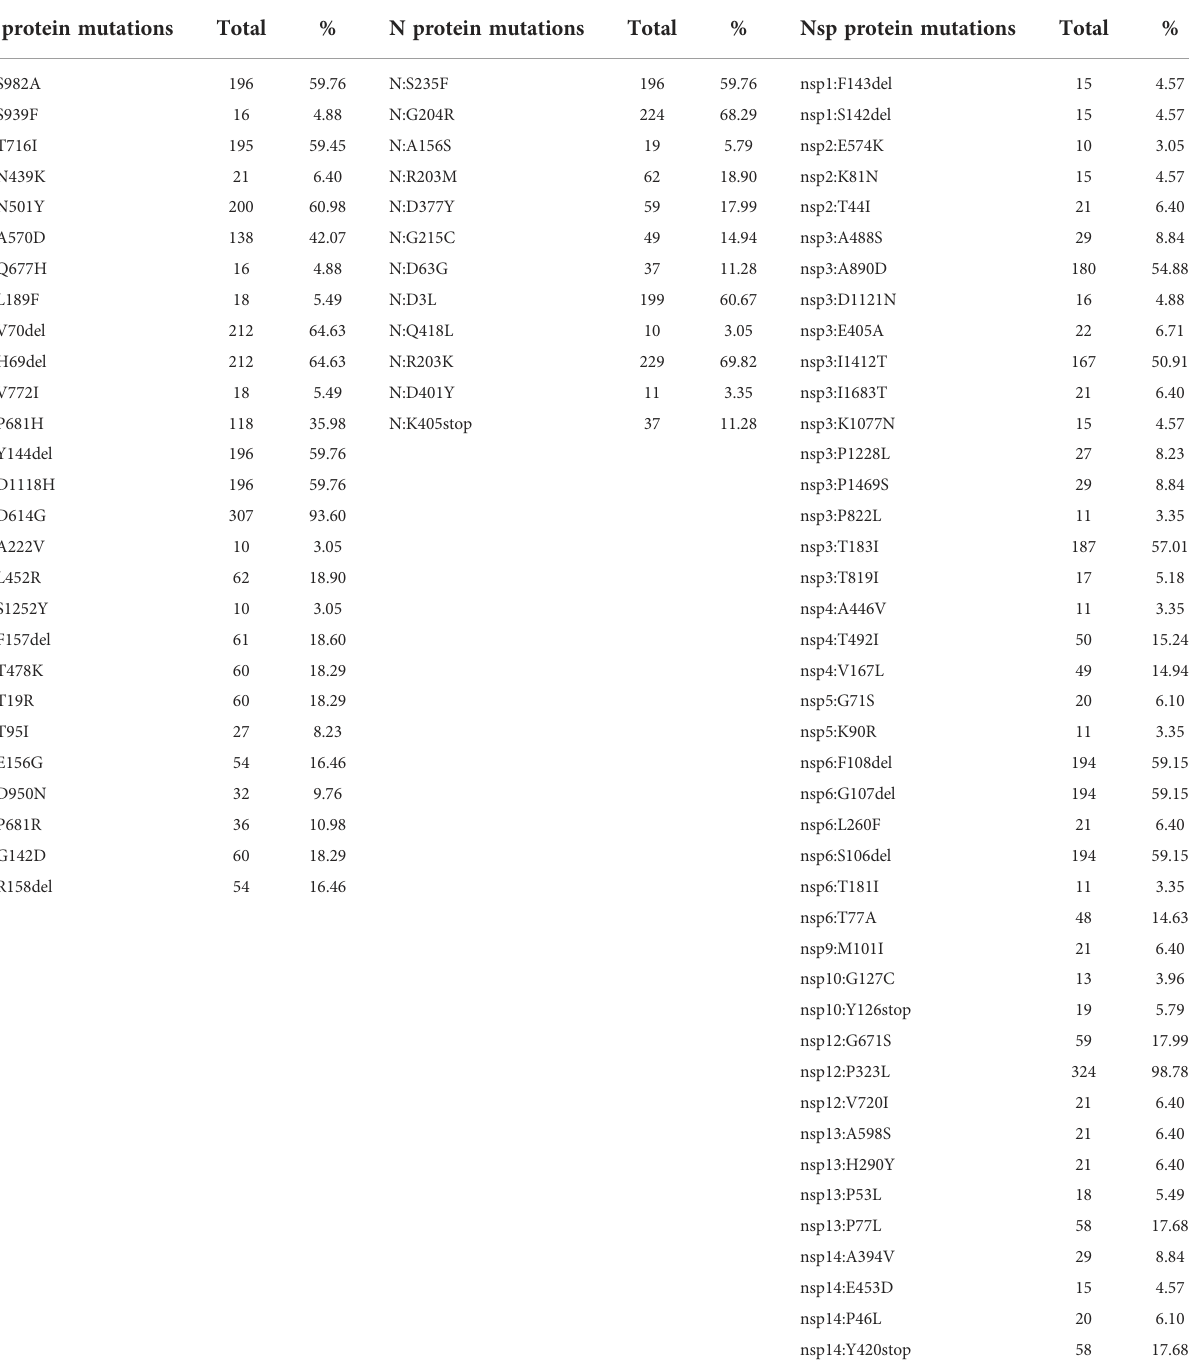
TABLE 1 A comprehensive overview of all detected mutations in the S, N and ORF1ab proteins. S protein